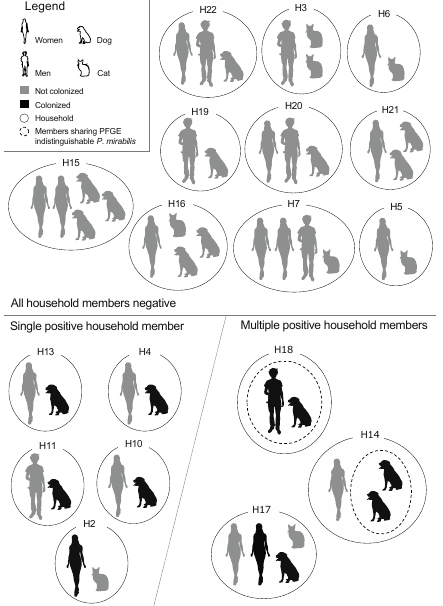
Figure 1. Fecal colonization and within-household sharing of P. mirabilis .